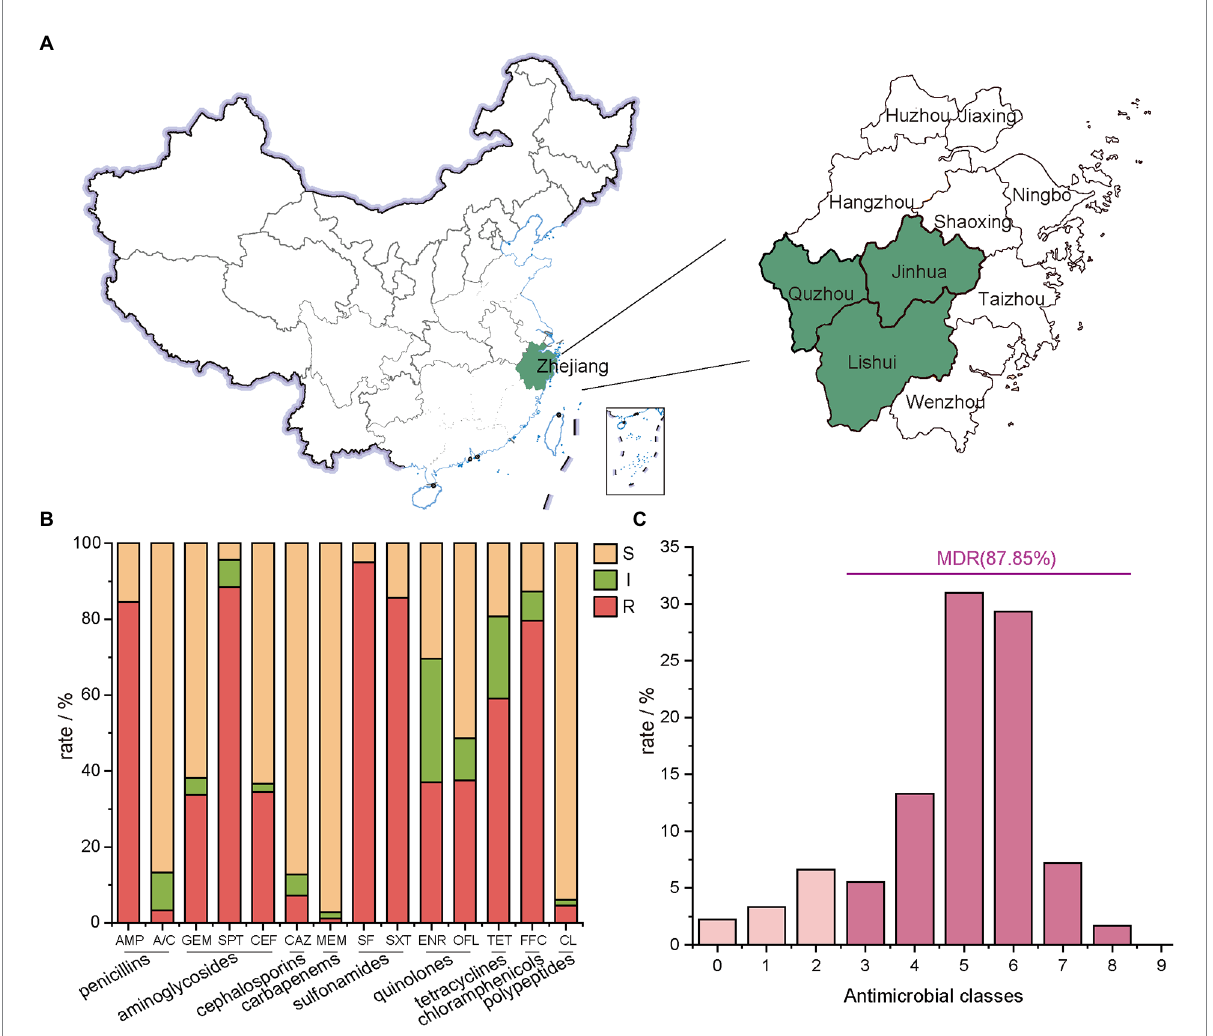
FIGURE 1 Geographical distribution of the sampling areas in Zhejiang Provinces, China, and AMR rates of E. coli isolates. (A) Sample sources of 181 strains of E. coli, Zhejiang Province in this study are shaded in green; (B) the number of E. coli isolates from farms in Zhejiang Province resistant to different antibiotics. In this experiment, 14 antibiotics with inflection points were divided into 9 categories; (C) the distribution of MDR